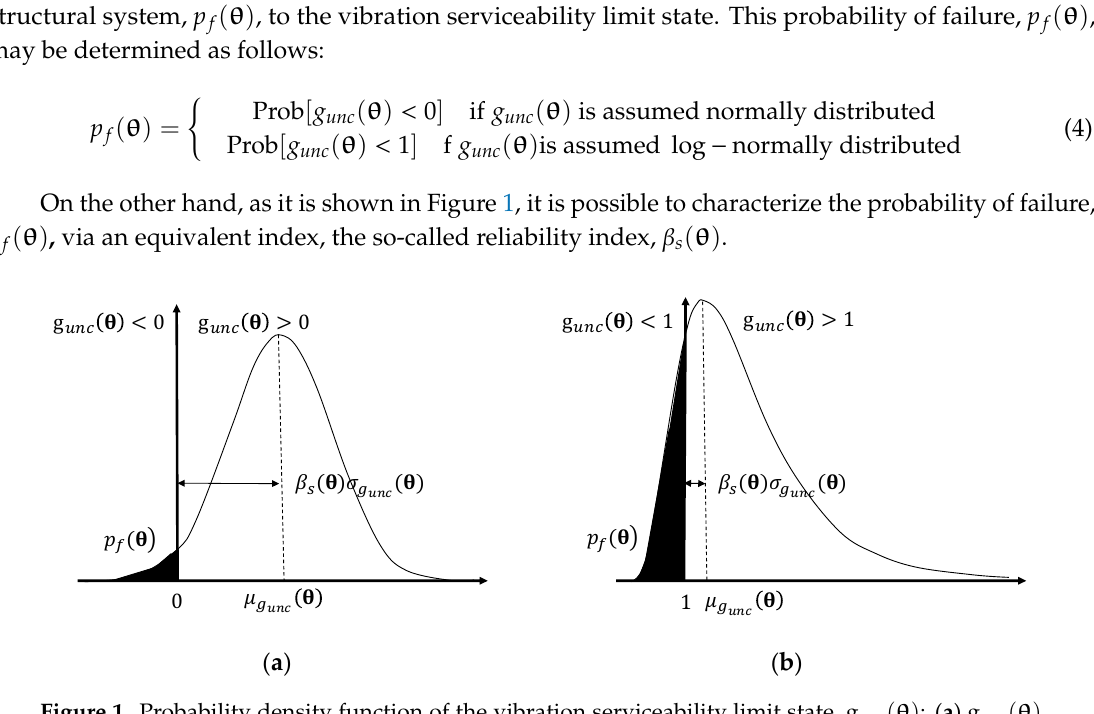
Figure 1. Probability density function of the vibration serviceability limit state, g (cid:3048)(cid:3041)(cid:3030) ((cid:2752)) : ( a ) g (cid:3048)(cid:3041)(cid:3030) ((cid:2752)) follows a normal distribution; and ( b ) g (cid:3048)(cid:3041)(cid:3030) ((cid:2752)) follows a log-normal distribution.